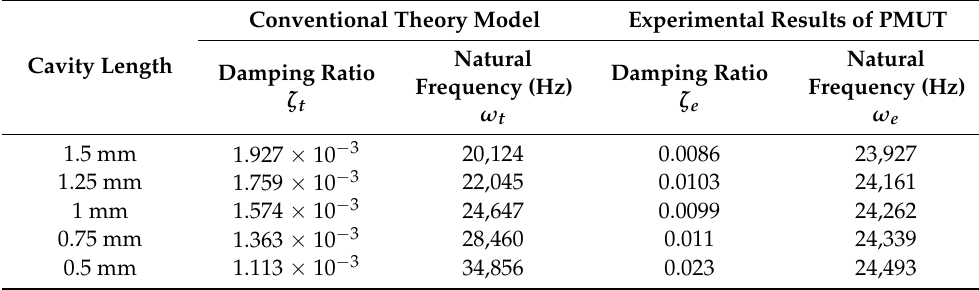
Table 4. Results of adjusting the factors of natural resonant frequency, damping ratio, effective mass, and viscous damper for varied volumes of Helmholtz resonant cavity.